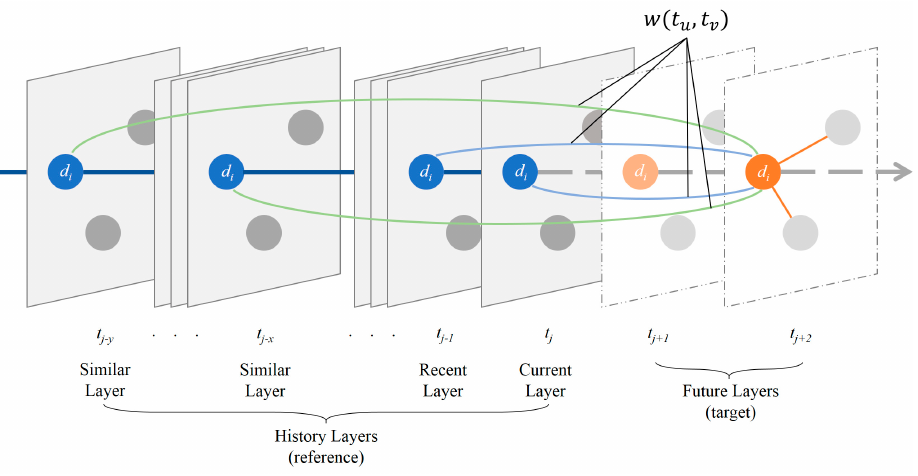
Figure 4. PM2.5 time series of adjacent devices within 5 km.